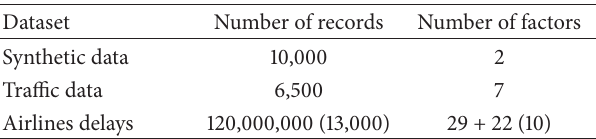
Table 1: Characteristics of the